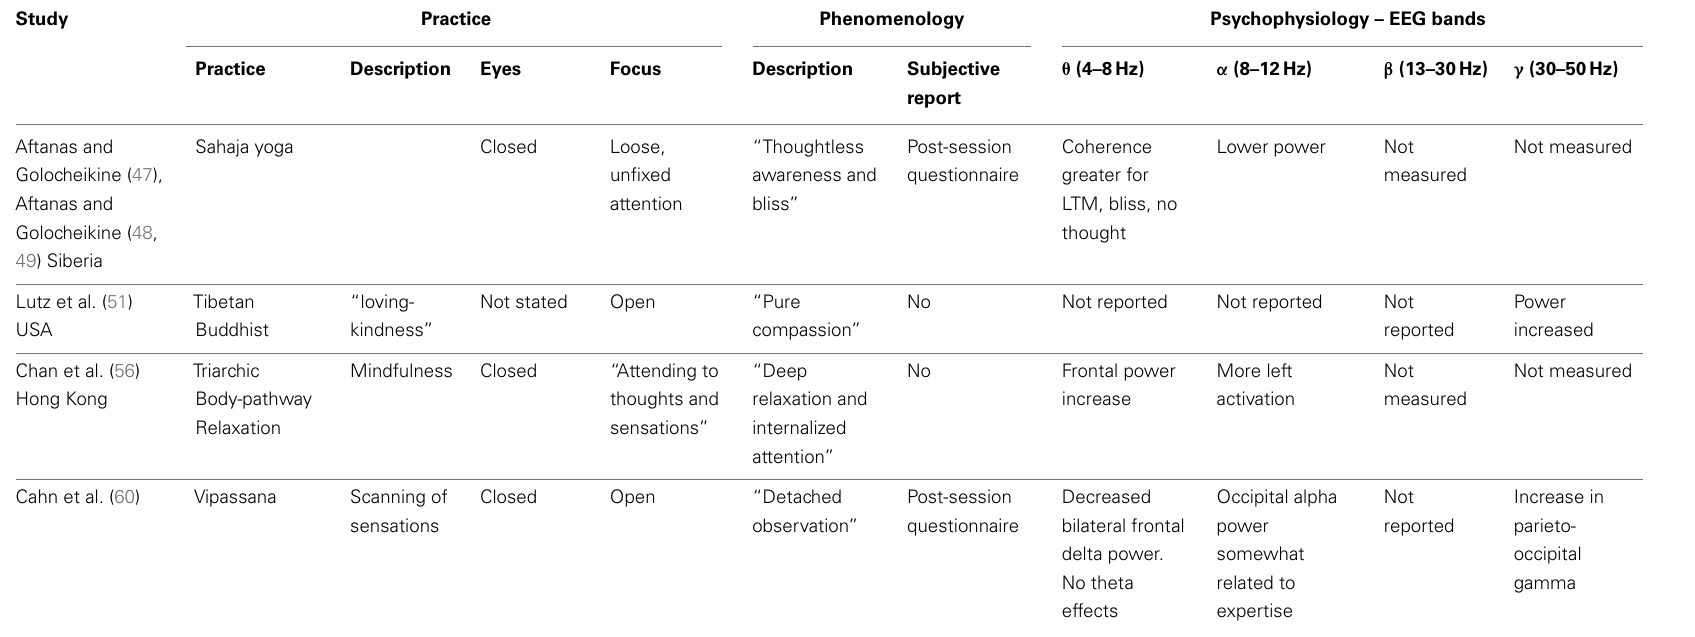
Table 3 | Studies using open monitoring meditation